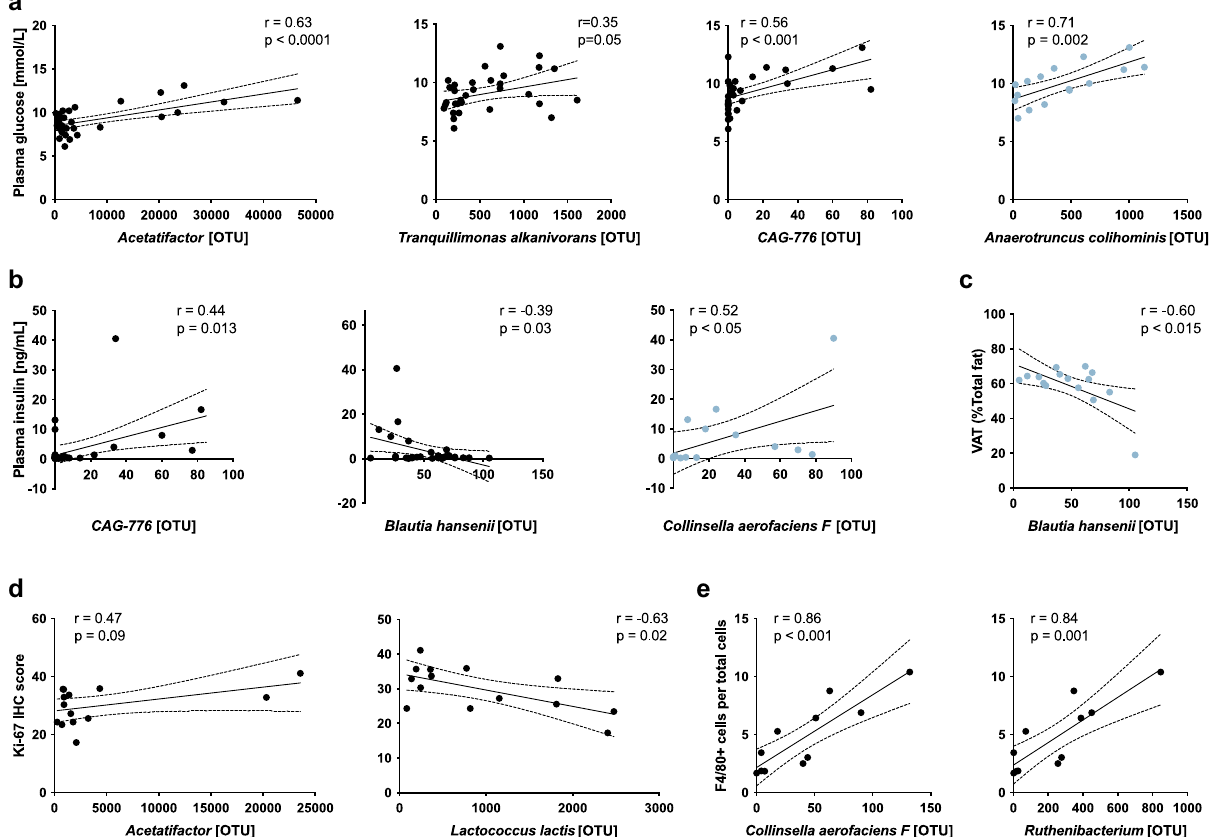
Fig. 4 Correlation between bacterial species and metabolic or phenotypic parameters. Bacterial species that were differentially abundant between the sexes and impacted by ligand treatment in males showed a correlation with a plasma glucose levels n = 32 sexes combined, n = 16 for males only in blue), b insulin levels ( n = 31 sexes combined, n = 15 for males only in blue), c visceral adipose tissue (VAT) in relation to total fat (n = 16, males only), d with Ki67 immunohistochemistry (IHC) proliferation score ( n = 14, sexes combined), and e with F4/80 + macrophage colonic in fi ltration ( n = 11 sexes combined). Metabolic and phenotypic parameters were previously analyzed and reported 17 . The best fi t line was fi tted with 95% con fi dence intervals, r Pearson correlation coef fi cient, and P value from a two-tailed Student ’ s t